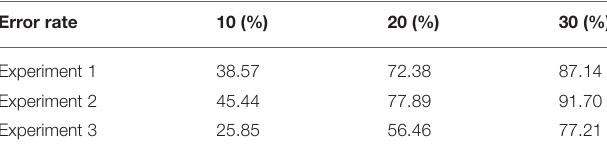
TABLE 2 | Accuracy of our